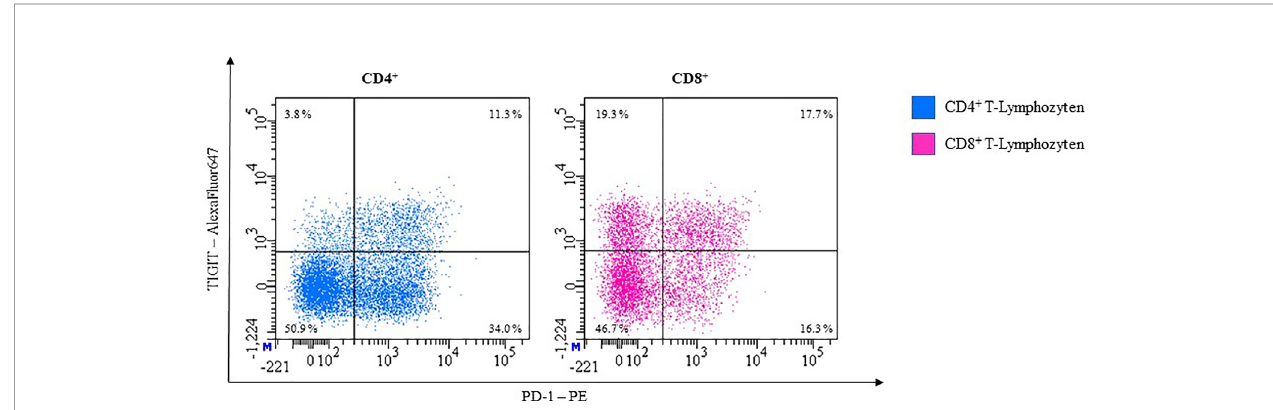
FIGURE 10 | Representative fl ow cytometric analysis of the expression of immune checkpoints TIGIT and PD-1 on unstimulated whole blood T lymphocytes of a healthy 41-year-old